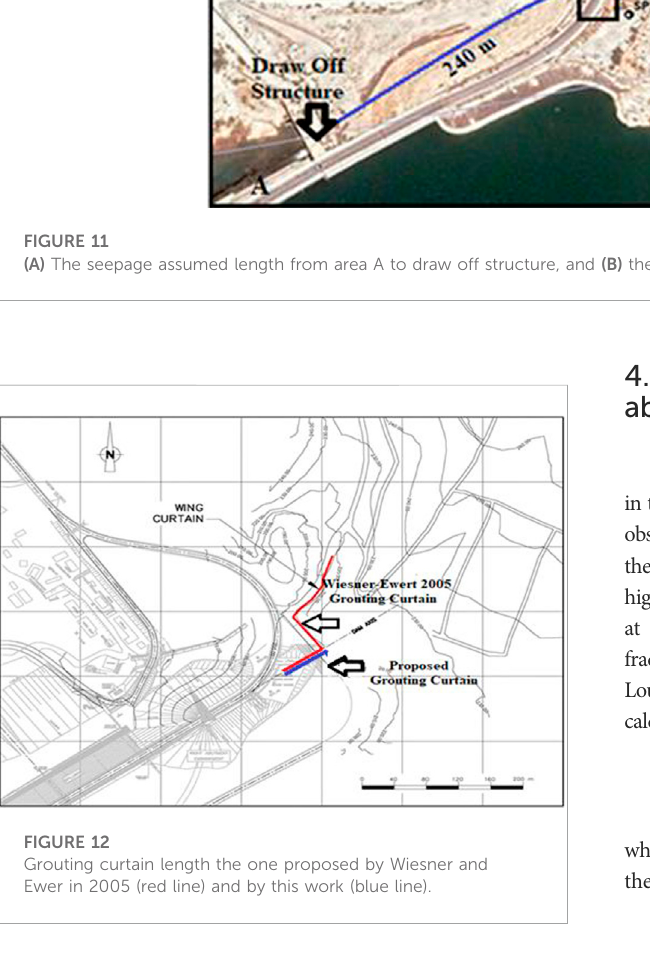
Figure 10), and the second fl ooded the area around the gallery stairs shaft walls and emerged inside the gallery at the top stair steps (green arrows in Figure 10), and it seems a small portion of this water went further down to appear at the culvert headwater side. In area B, the reservoir water seeped through it and continued its way downstream to emerge in the culvert headwater side too. The analysis in Section 4.3, last paragraph, found that the seepage volume through areas B and A represented 25 and 75%, respectively, of the total seepage water.